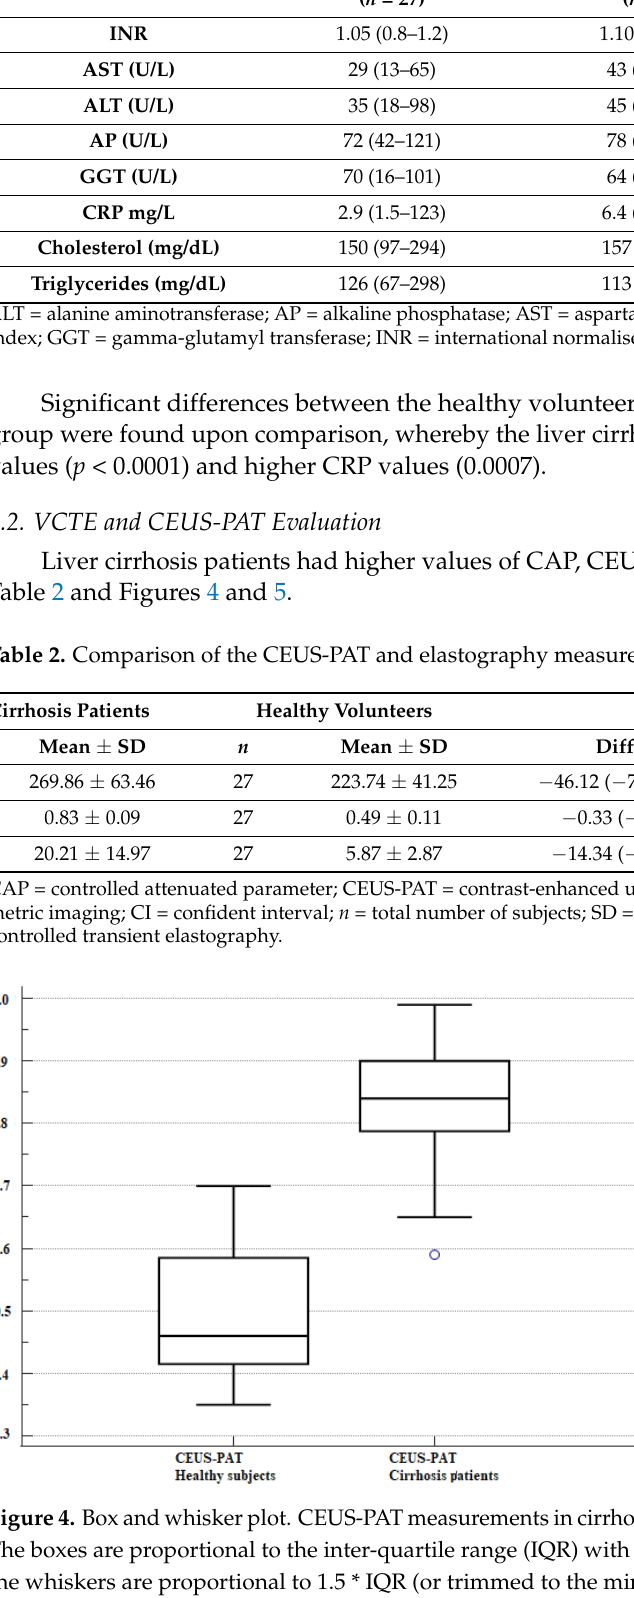
Figure 5. Box and whisker plot. VCTE measurements in cirrhosis patients and healthy volunteers. The boxes are proportional to the inter-quartile range (IQR) with medians marked in-between, and the whiskers are proportional to 1.5 * IQR (or trimmed to the minimum or maximum values). The bullet and the squares are outliers. 3.3. Performance of CEUS-PAT in Detecting Liver Cirrhosis Based on Youden’s index, the optimal cut-off value for detecting liver cirrhosis was a ratio of AtPI between the kidney and liver of >0.7, with an AUC of 0.98, p < 0.001, Se = 89.19%, Sp = 100%, PPV = 100%, and NPV = 87.1%. (Figure 6) 0102030 40 50 60